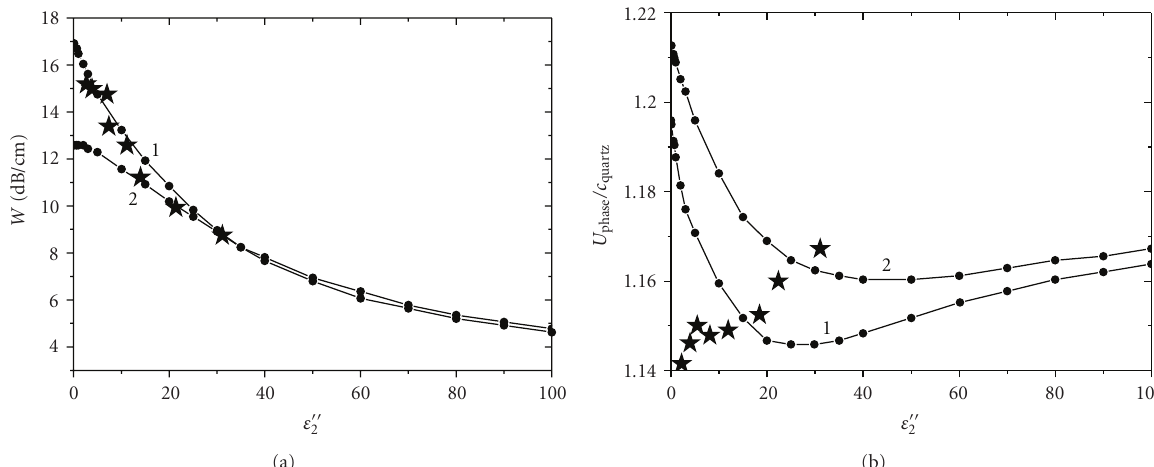
Figure 3: The dependence of the attenuation coe ffi cient (a) and the normalized phase velocity V phase /c quartz (b) to the light velocity in the quartz rod ( ε 1 = 3 . 8 + i 0 . 0001) for the wave in cylinder round rod. Complex permittivity of the outer medium is ε (cid:2) 2 = 10 (curve 1) and ε (cid:2) 2 = 20 (curve 2). The operating frequency is 31.82GHz. The stars denote experimental data points from [14] (the outer medium was taken as water-ethanol solutions at 23 ◦ C from 10% to 70% ethanol in water [22, 23]). At big values of imaginary complex permittivity part ε (cid:2)(cid:2) 2